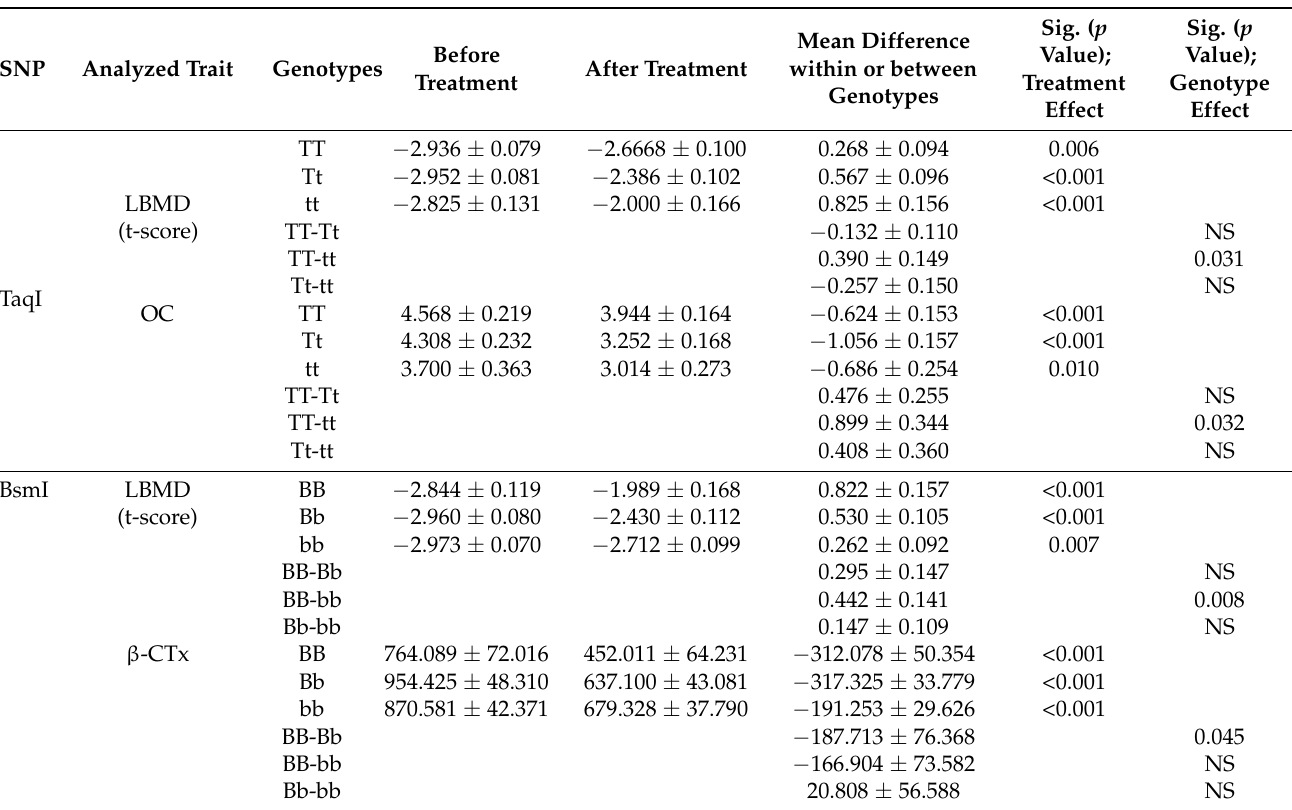
Table 8. Significant changes in osteoporosis-related traits after raloxifene therapy in relation to the VDR